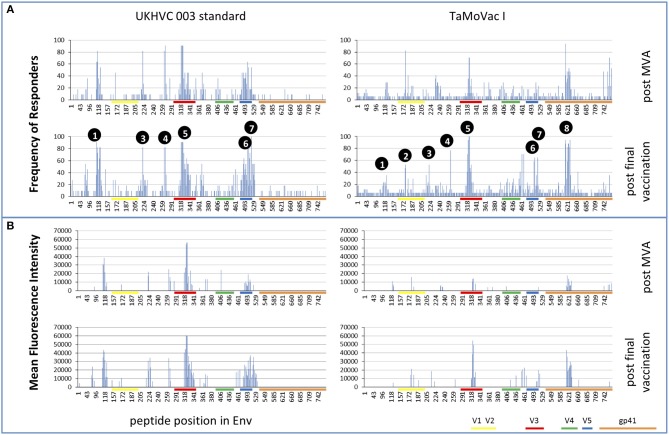
Mapping of antigenic regions targeted by Env-specific IgG responses in UKHVC003 and TaMoVac01. The frequency of responders (FOR, y-axis) to antigenic regions within the Envelope protein (A) after the second MVA (first row) and after CN54rgp140/GLA boosts (second row) is shown for the UKHVC_003 standard group (left panels, n = 11), and for TaMoVac01 recipients (right panels, n = 17). Immunodominant regions 1–8 are indicated. For region-specific IgG responses occurring in at least 25% of vaccinees, the mean fluorescence intensity (MFI) is shown in (B) after MVA (third row) and after CN54rgp140/GLA boosts (fourth row) for the two groups. IgG responses against individual antigenic regions were considered positive, if the corresponding fluorescence intensity was above 2,500 after subtraction of the pre-vaccination value. Mapping results from UKHVC003 were partially published previously (17).